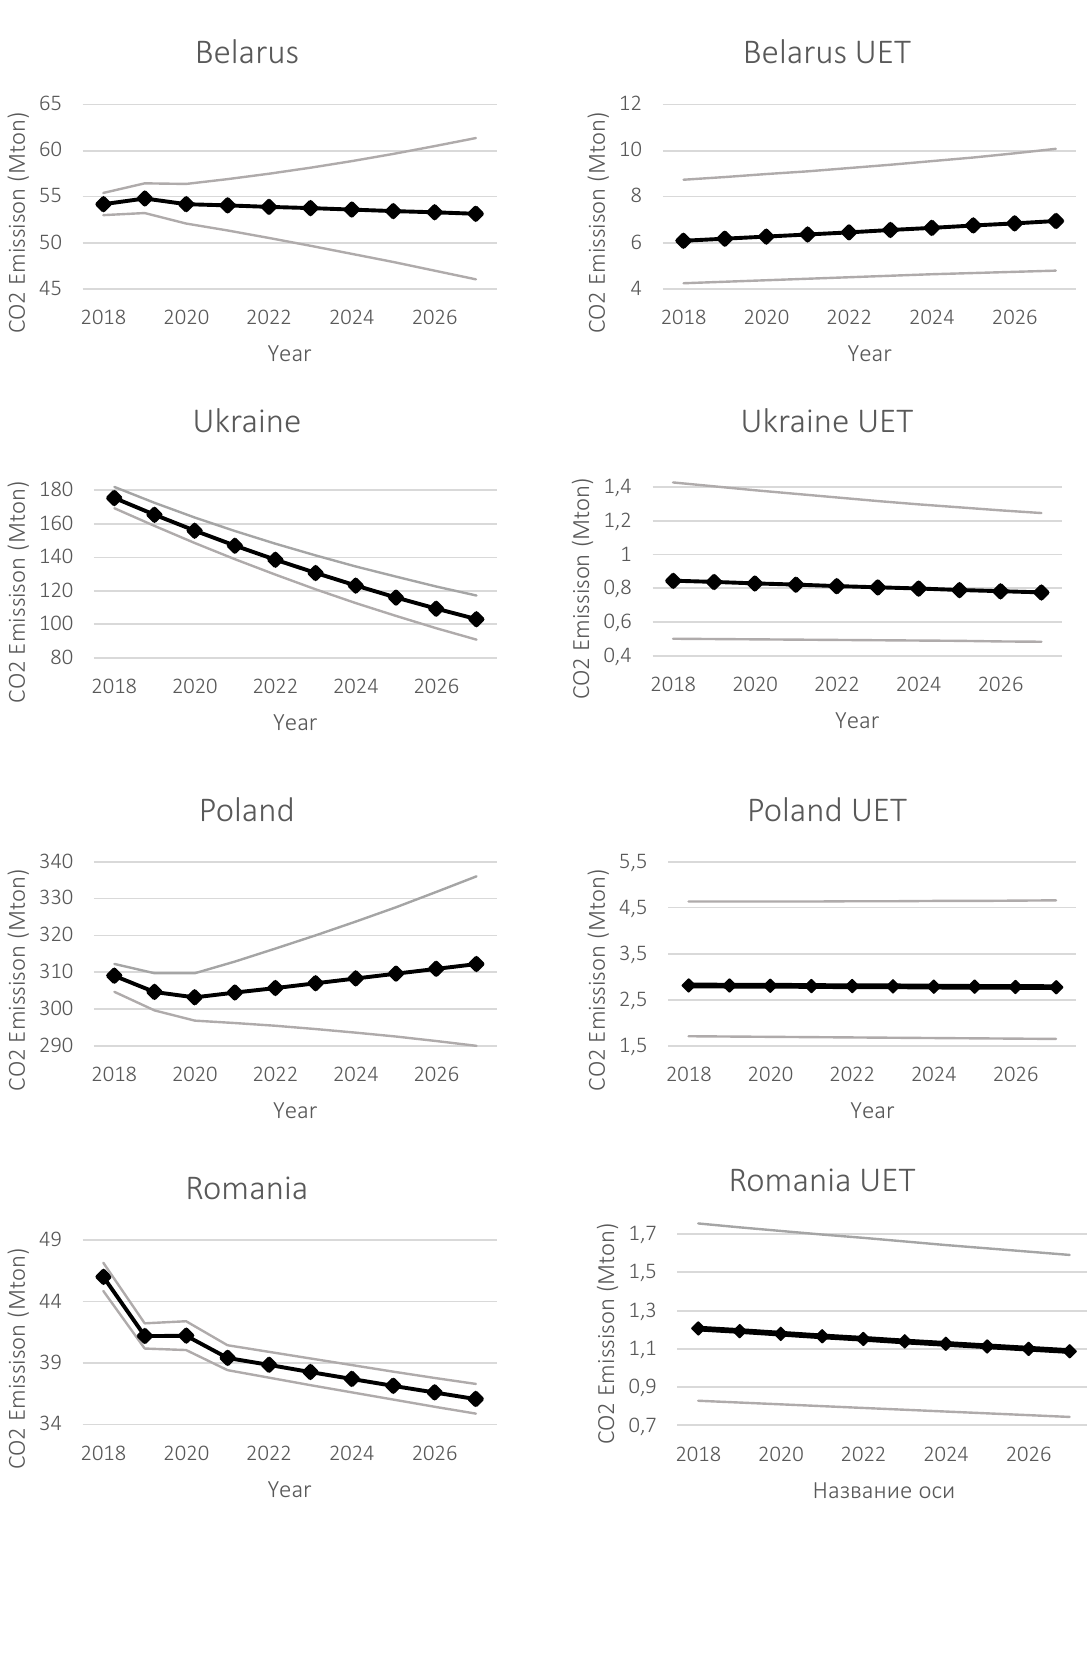
Figure A2. Forecast results and UETs for each